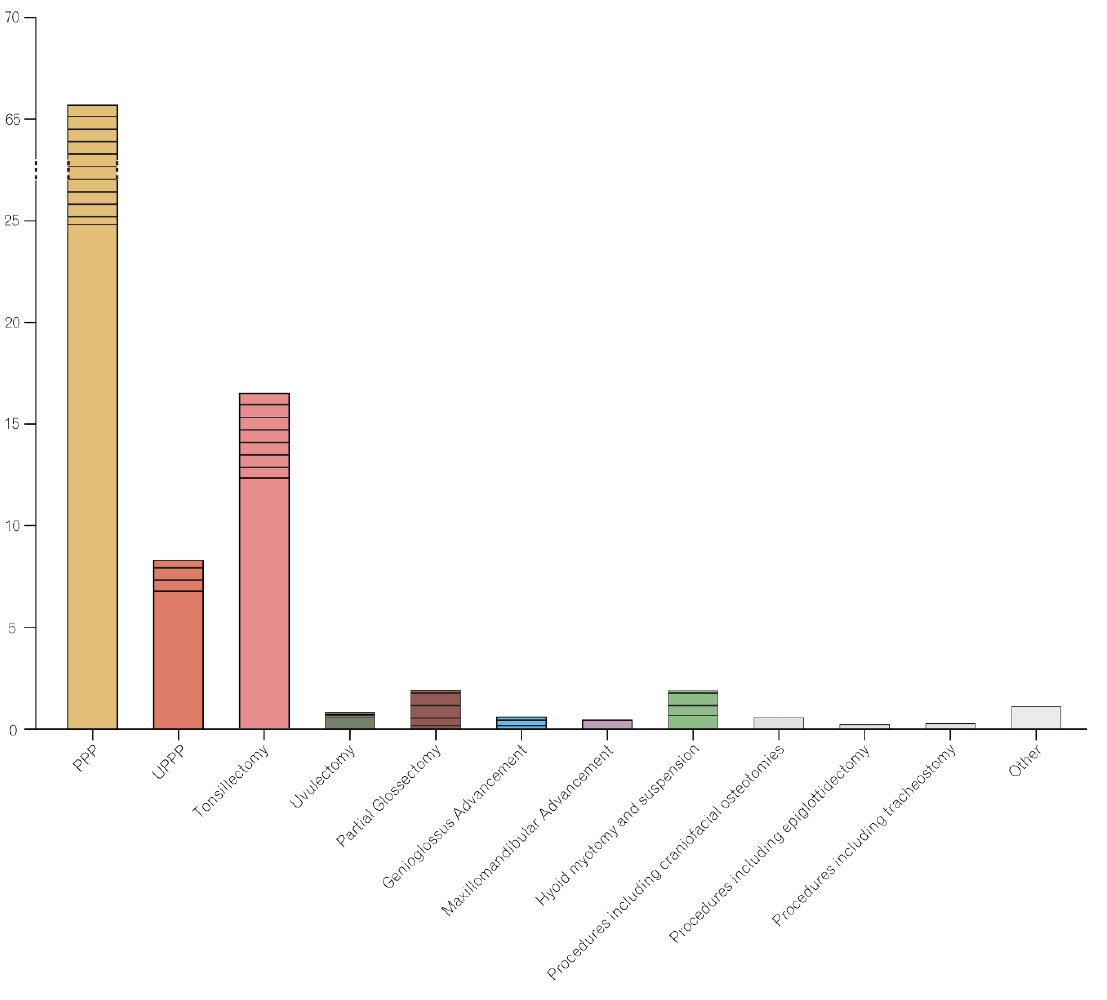
Figure 1. Procedure distribution. Procedures performed concomitantly with other procedures (com- bined procedures) are shown with a striped pattern. The majority of procedures (>65%) were PPPs, followed by tonsillectomies. The exact numbers are shown in Table 3. PPP, palatopharyngoplasty; UPPP, uvulopalatopharyngoplasty. Table 4. Operative and postoperative outcomes for all patients undergoing head and neck OSA surgery. Reported as n (%), unless otherwise stated.